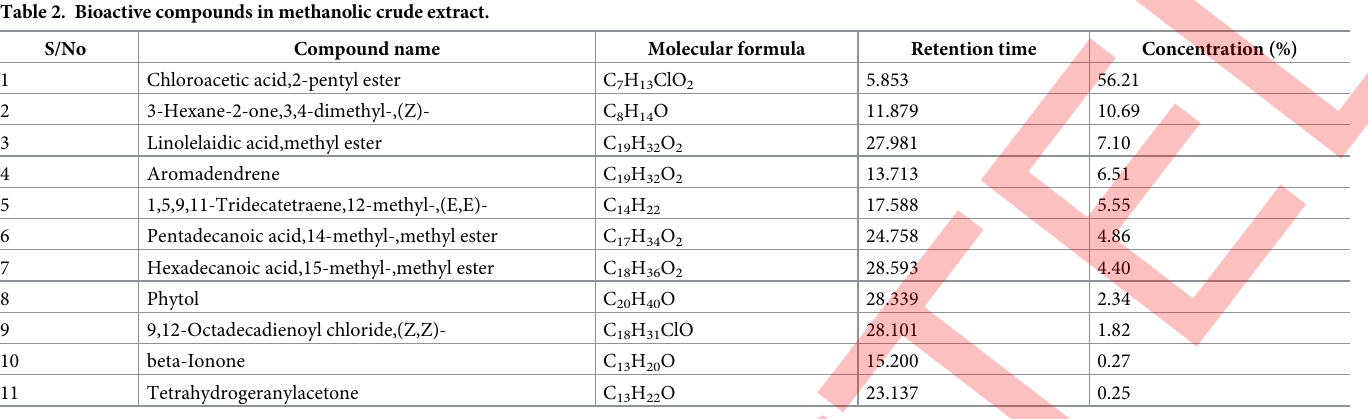
Table 2. Bioactive compounds in methanolic crude